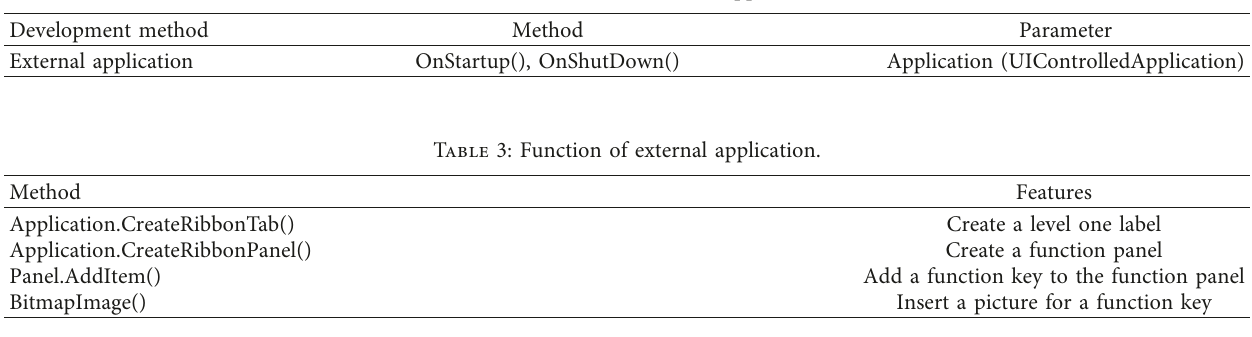
Table 2: Parameters of external application.